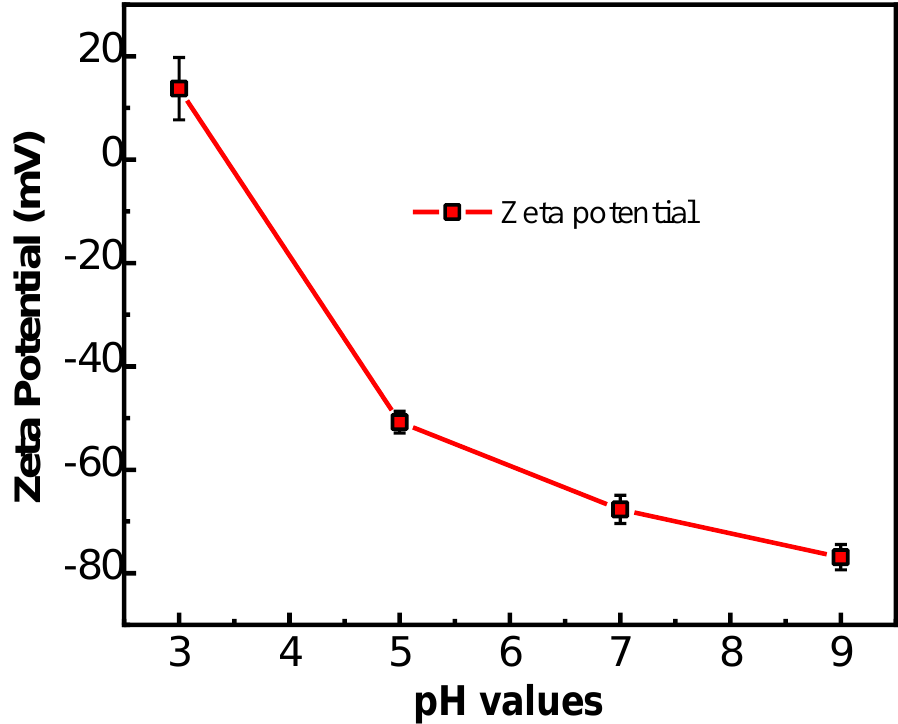
Figure 5. Potential values of PMIA HF TFC NF membrane at various pH values.